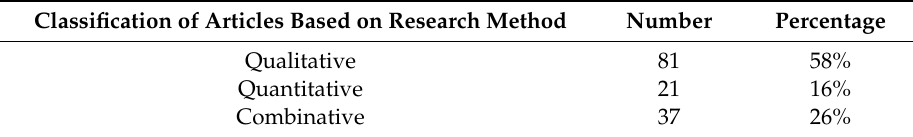
Figure 3. Classification of articles based on article type. Table 2. Methods used in the reviewed articles.